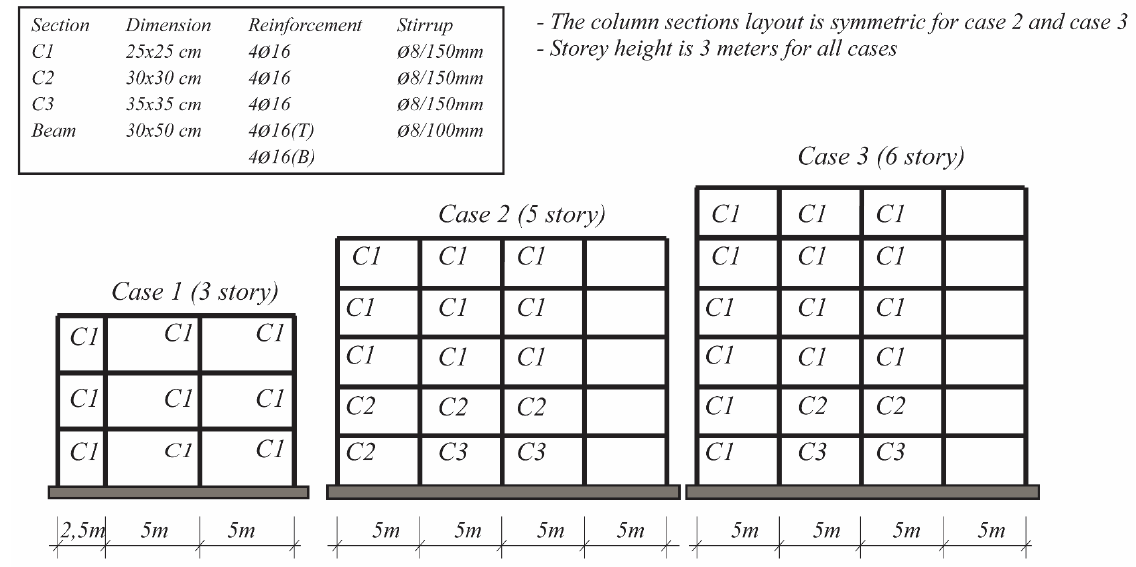
Figure 5. Geometry and sectional details of the case study